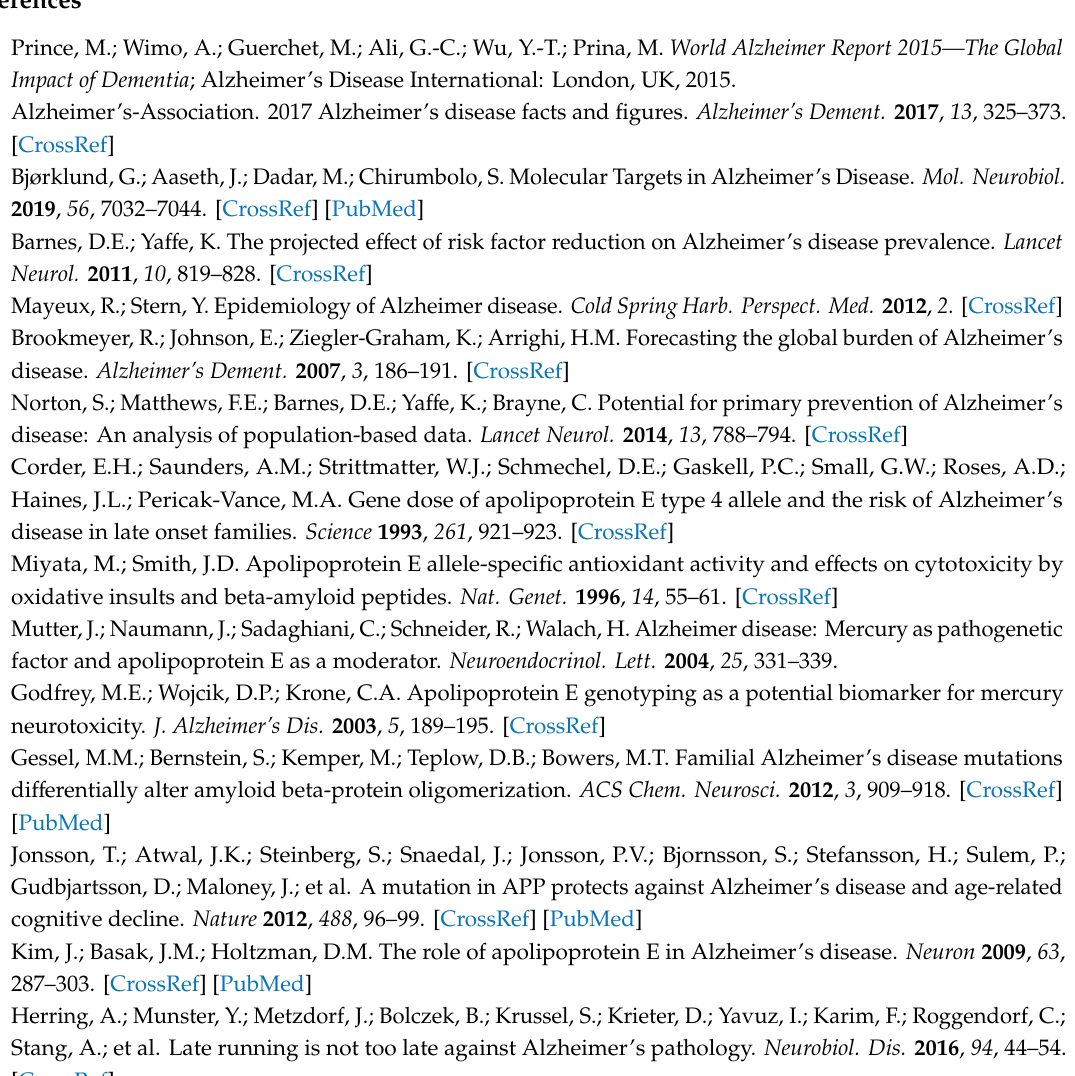
bu ff er, Figure S5: Two-dimensional (2D) NMR 1 H– 15 N-HSQC titration experiments showing A β 40 residue-specific perturbations from Hg(II) ions in SDS